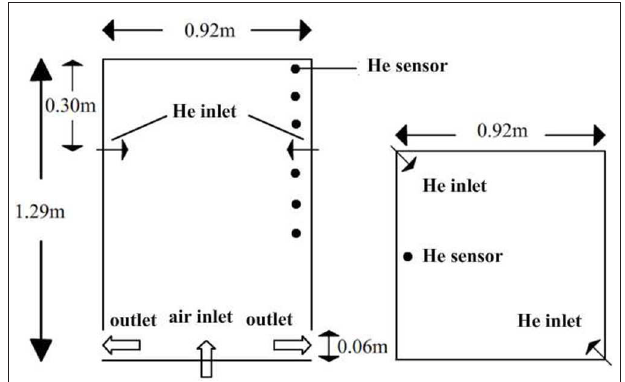
FIGURE 1 | Experiment